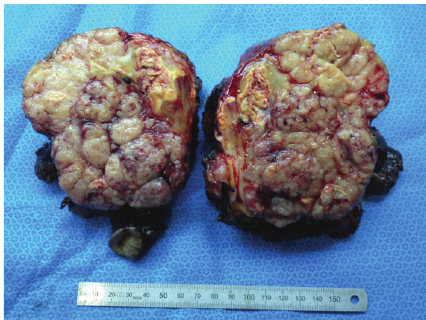
Figure 2: Cross section of the solid tumour with central necrosis and intact